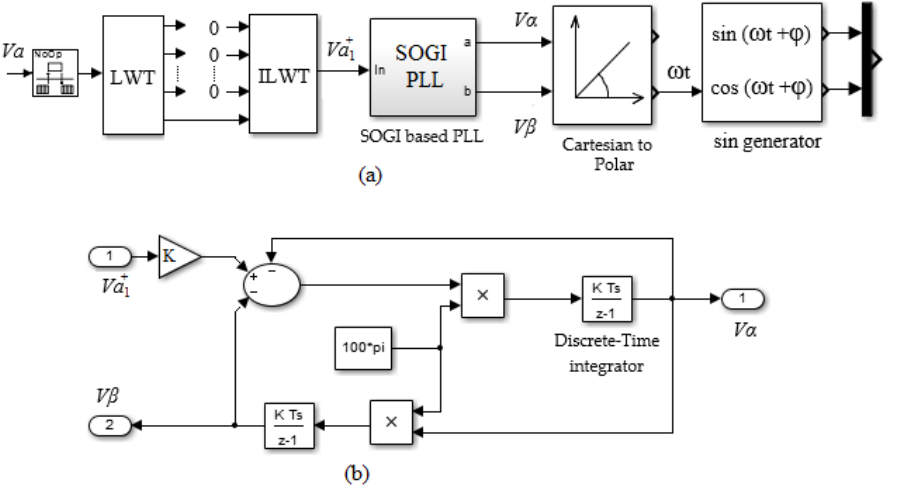
Figure 4. Block diagram of: ( a ) Wavelet-based signals generator; ( b ) internal structure of the SOGI-based phase locked loop (PLL).